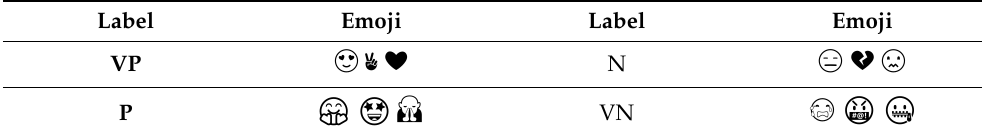
Table 7. Emojis partial collection.